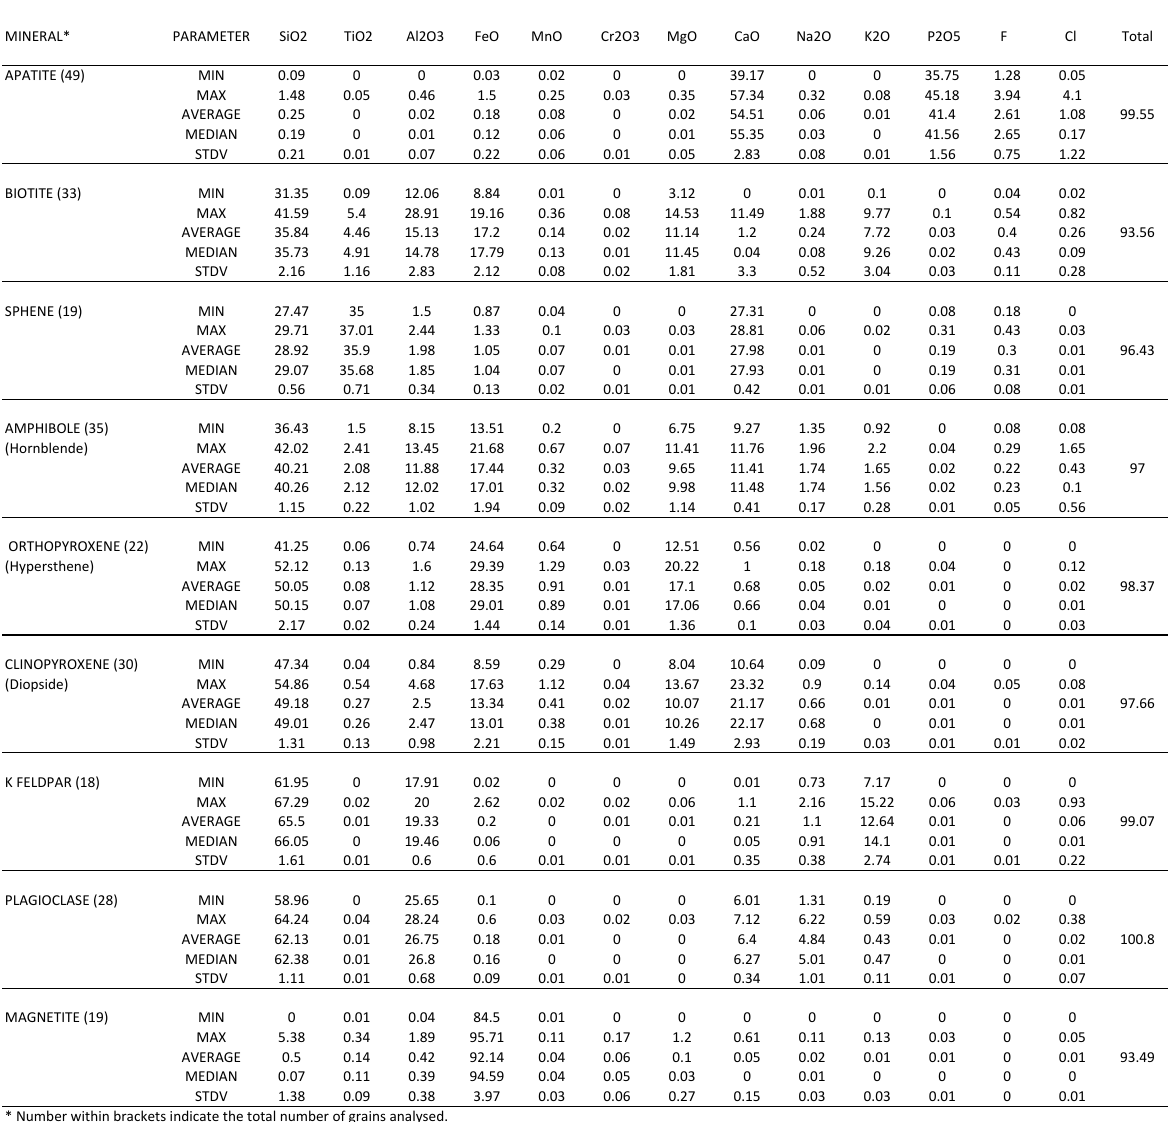
* Number within brackets indicate the total number of grains